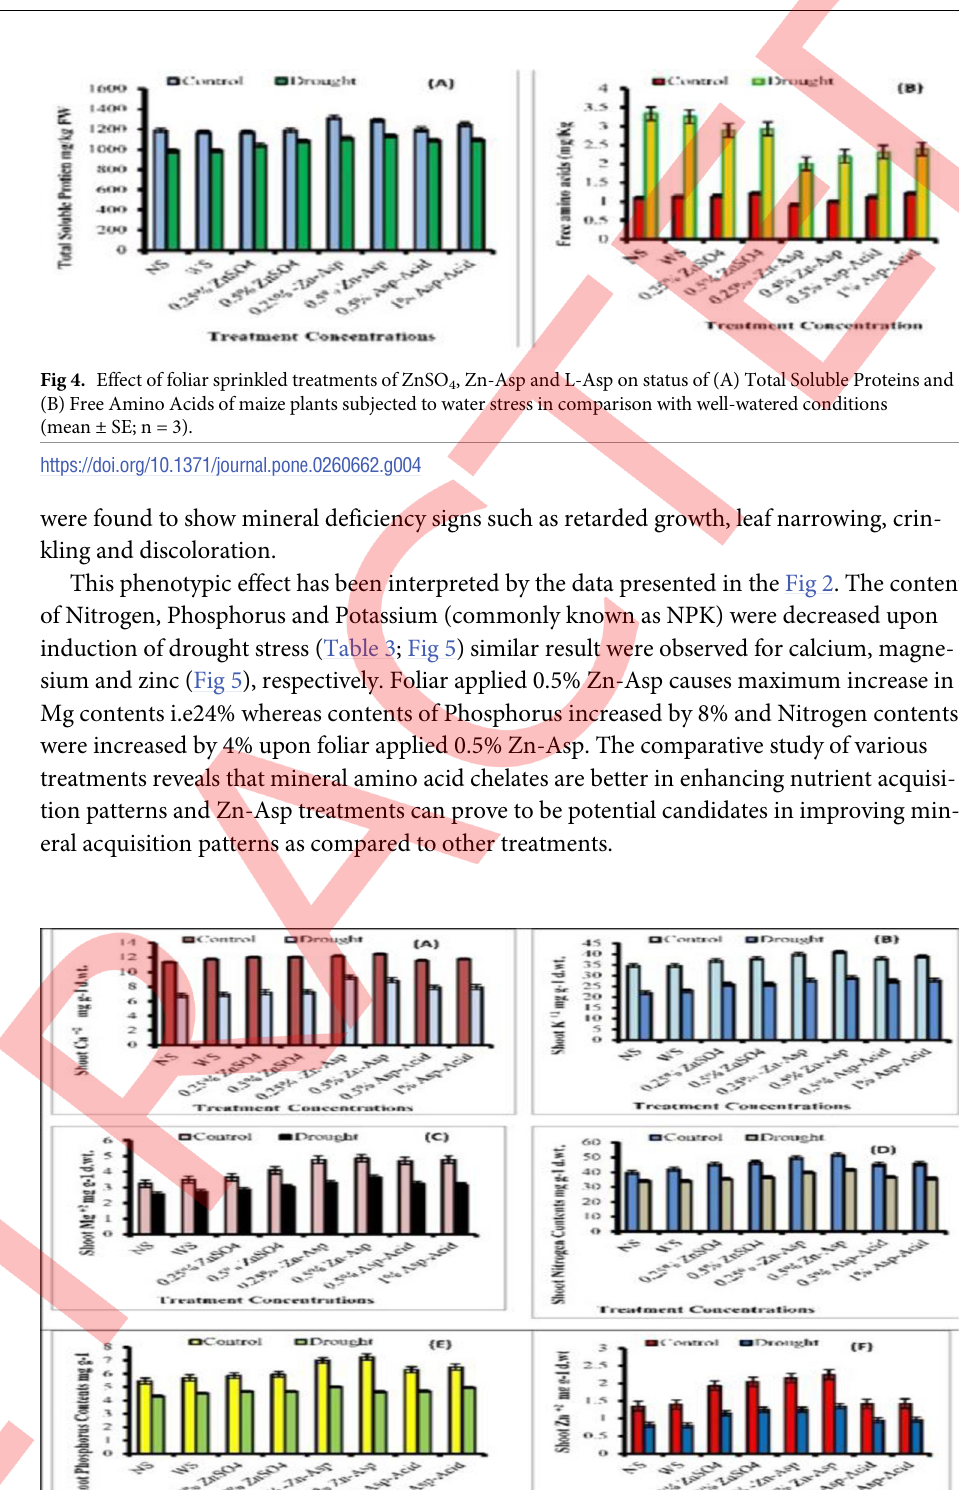
Fig 5. Effect of foliar sprinkled treatments of ZnSO 4 , Zn-Asp and L-Asp on status of shoot minerals (A) Calcium (B) Potassium (C) Magnesium (D) Nitrogen (E) Phosphorus and (F) Zinc of maize plants subjected to water stress in comparison with well watered conditions (mean ± SE; n =